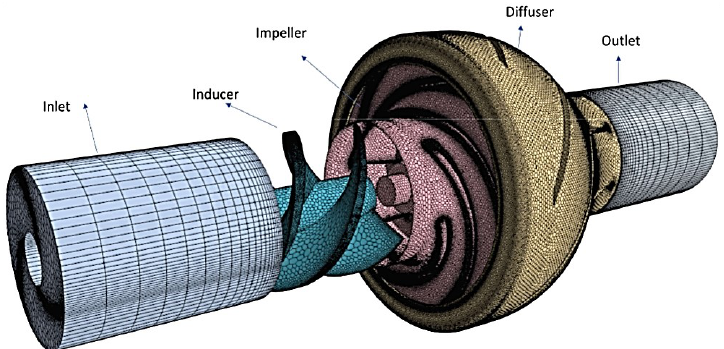
Figure 1. Structure of counter-rotating pump